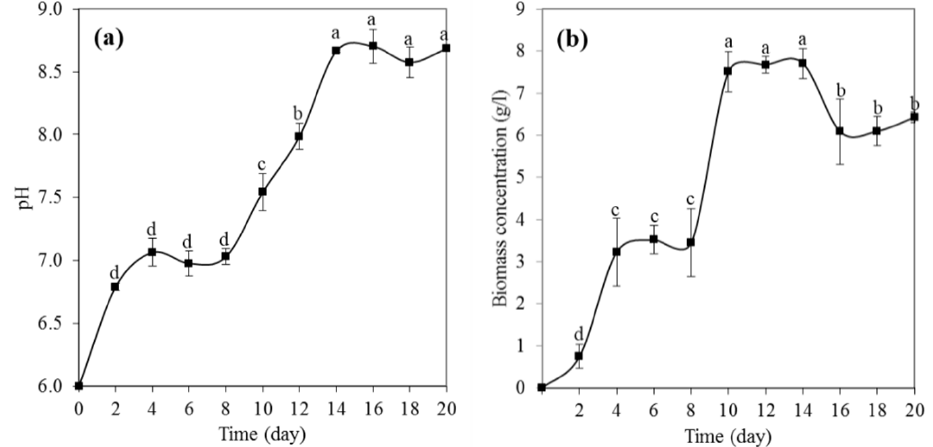
Figure 4. pH of the P. melonis 502 cultural fluid ( a ) and biomass concentration ( b ) in shake cultures. The values represent the average ± SD of three replicates. Mean growth rates followed by different letters are significantly different according to Duncan’s multiple range test at p ≤ 0.05.